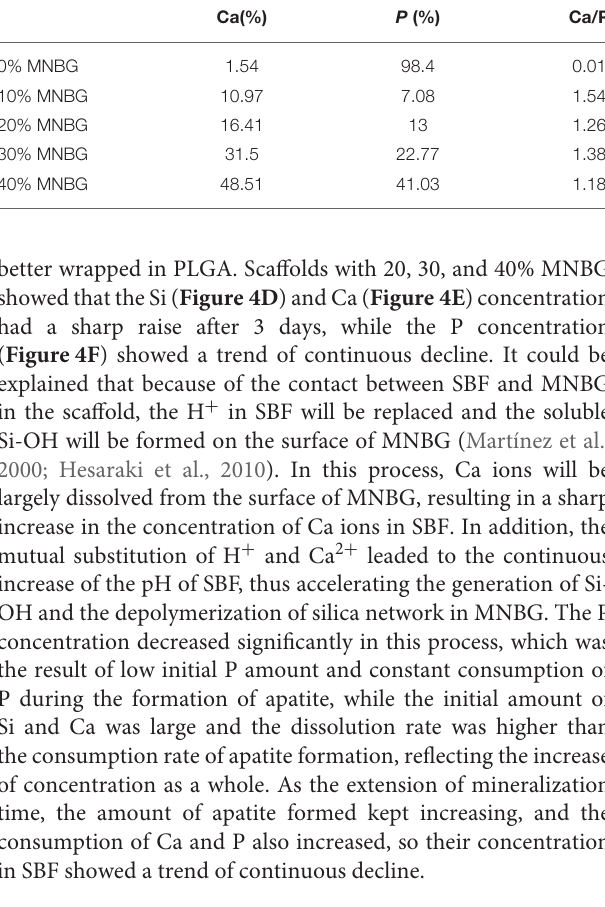
TABLE 2 | The ratio of Ca to P after scaffolds immersion in SBF for 7 days. Ca(%) P (%)